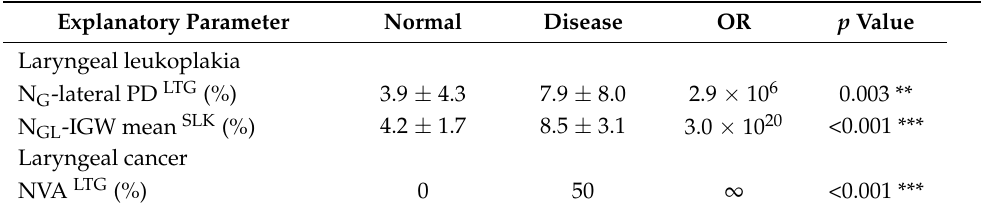
Table 10. Key parameters of laryngeal leukoplakia and cancer. Explanatory Parameter Normal Disease OR p Value Laryngeal leukoplakia N G -lateral PD LTG (%) Laryngeal cancer NVA LTG (%) 0